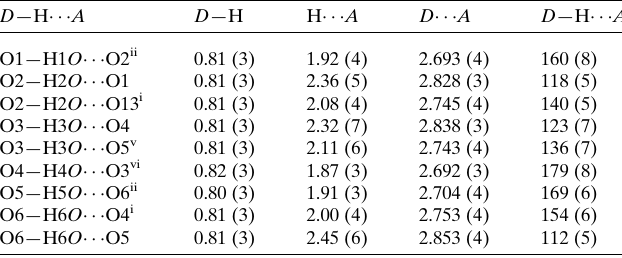
Table 1 Hydrogen-bond geometry (A˚ , (cid:4) ).